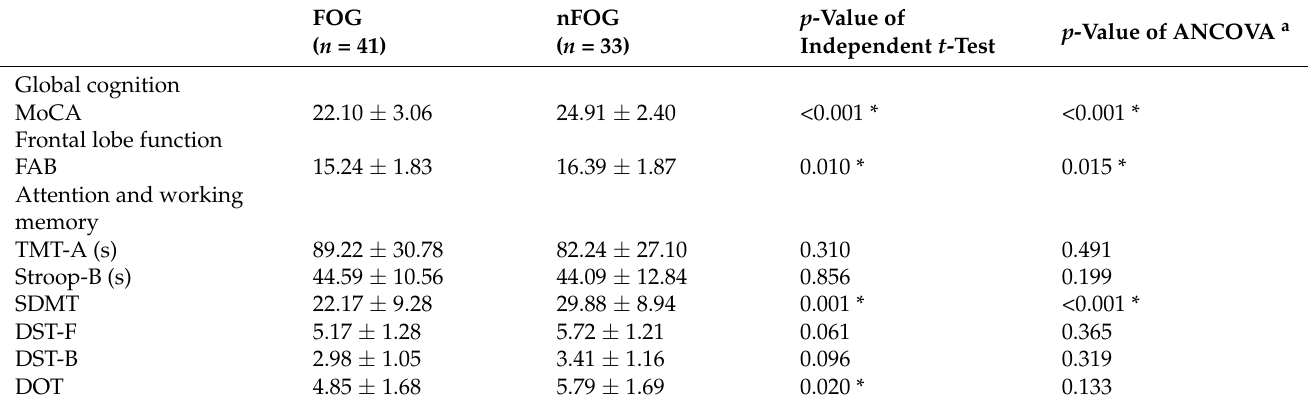
Table 3. Differences in cognitive performance between FOG and